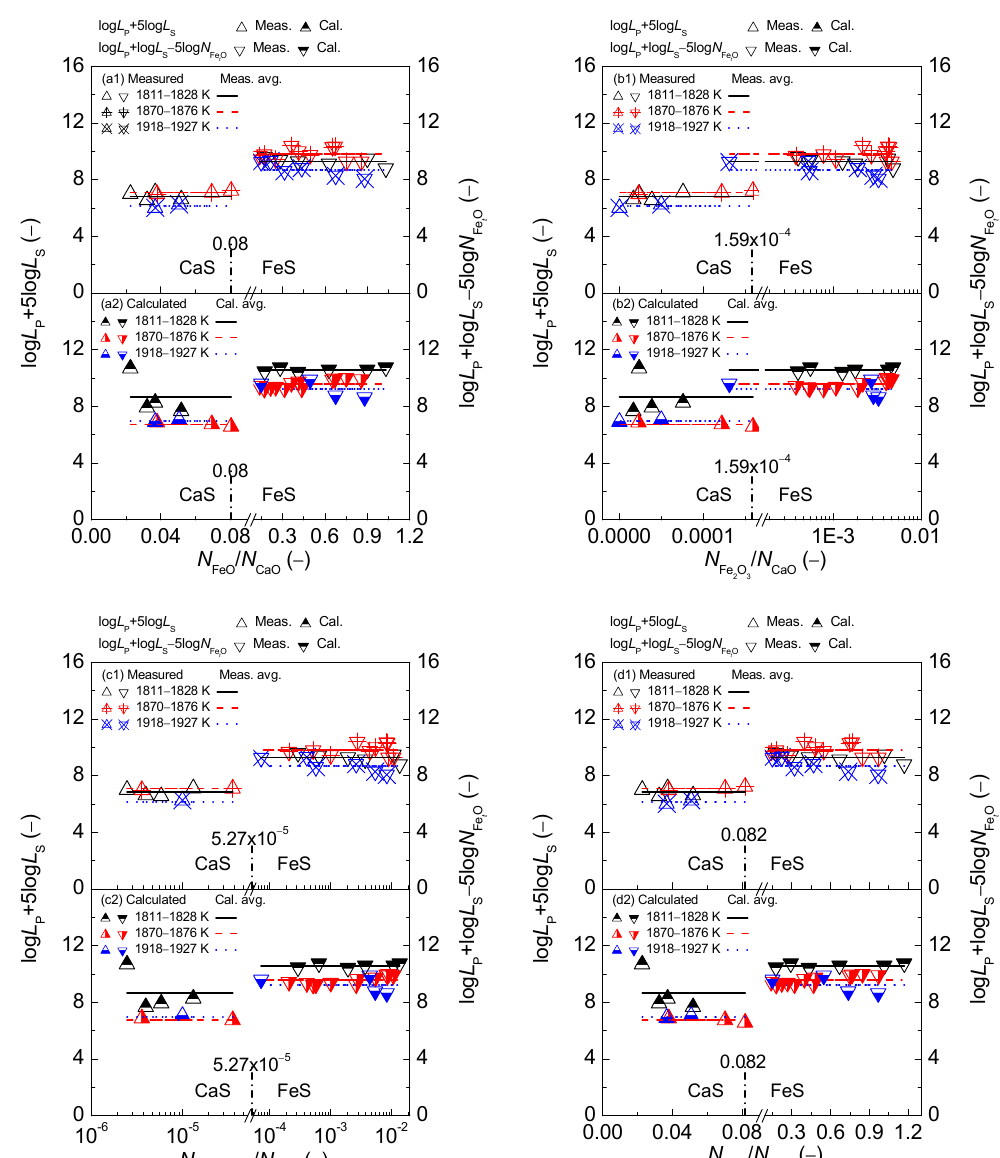
Figure 11. Relationship of the mass action concentration ratio N FeO / N CaO ( a ) or N Fe N FeO · Fe / N CaO ( c ) or N Fe / N CaO ( d ) against the determined term log L Figure 11 . Relationship of the mass action concentration ratio t O 2 O 3 + log L − 5log N or log L after Ban-ya et al. [1] in the first layer or Fe t O P, measured S, measured